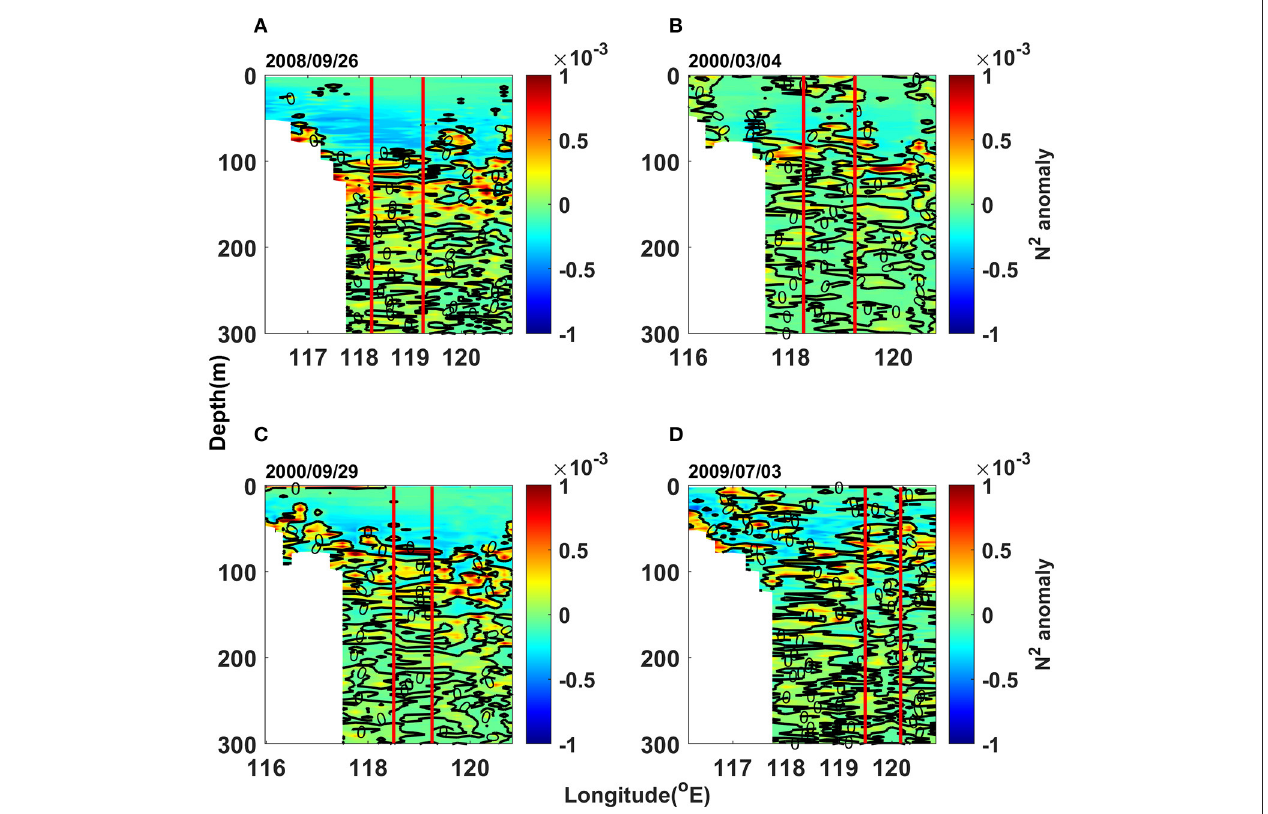
FIGURE 9 | Anomalies of squared buoyancy frequency on (A) September 26, 2008 (AE1), (B) March 4, 2000 (CE8), (C) September 29, 2000 (AE4), and (D) July 3, 2009 (CE10), showing the background situation of ocean stratification around the eddies. The two red vertical lines show the region of eddies confirmed with satellite altimeters. The left (right) panel is for the cases of anticyclonic (cyclonic) eddies, while the upper (lower) panel is for the cases with (without) significant eddy pumping.